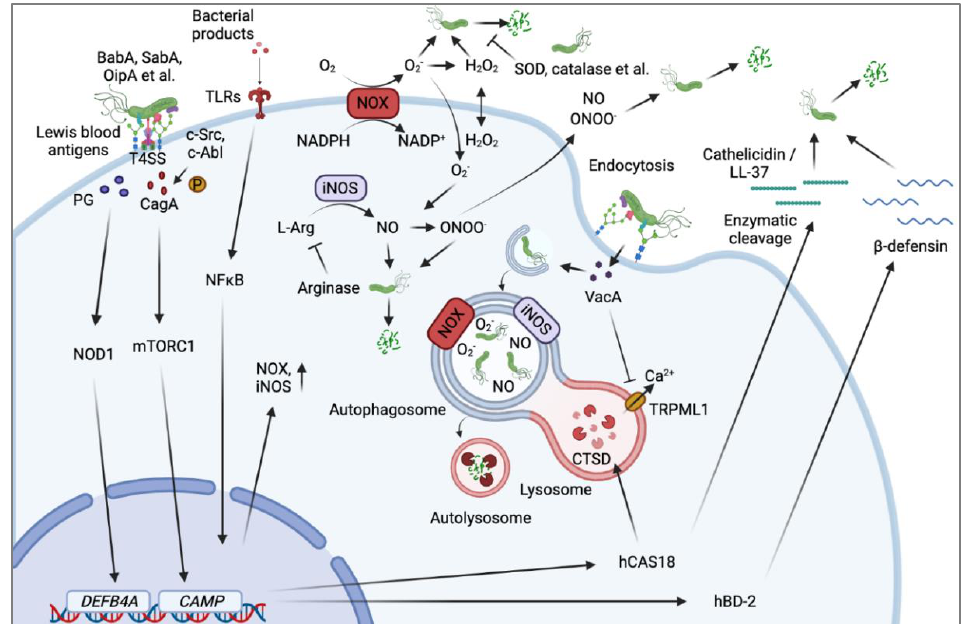
Figure 1. H. pylori infection and host antimicrobial response. H. pylori attach to host cells surface via bacterial outer membrane proteins (OMPs such as BabA, SabA, OipA, et al.) interacting with ligands (Lewis et al. blood group antigen) on cell surface. Once attached, the bacterial type IV secretion system (T4SS) delivers a variety of virulence factors into host cell. The translocated CagA is